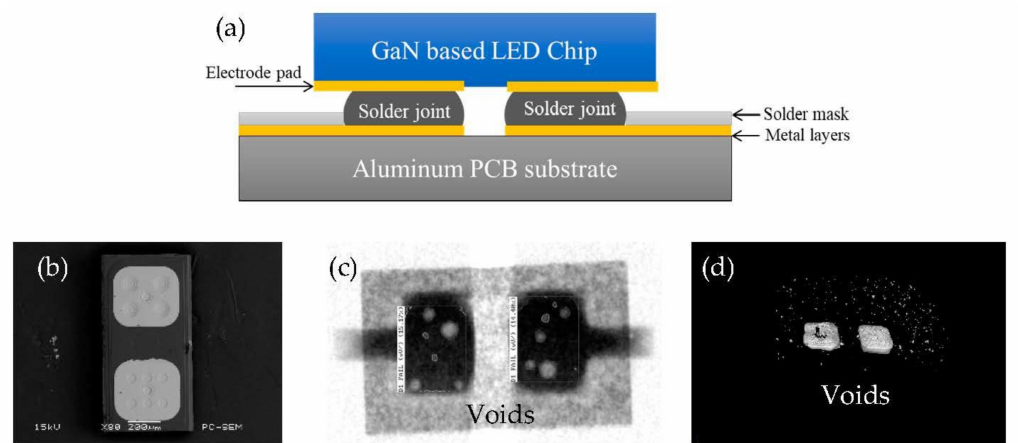
Figure 1. ( a ) The schematic diagram of test sample with a blue light emitting diode (LED) chip soldered on the aluminum PCB substrate; ( b ) the Scanning Electron Microscope (SEM) image of LED electrode pads; ( c ) the 2D and ( d ) 3D void distribution in the solder joints.